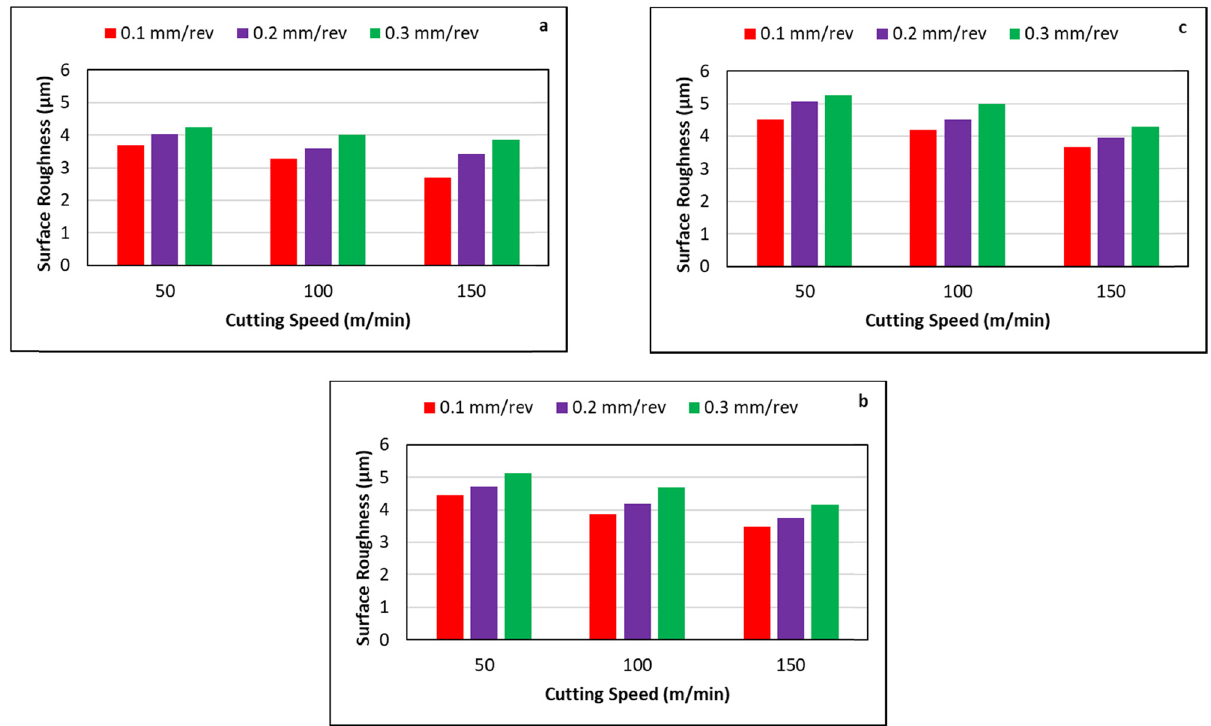
Figure 9: In fl uence of cutting speed on surface roughness at constant depth of cut 2 mm: ( a ) fi ber orientation 30°, ( b ) fi ber orientation 60°, and ( c ) fi ber orientation